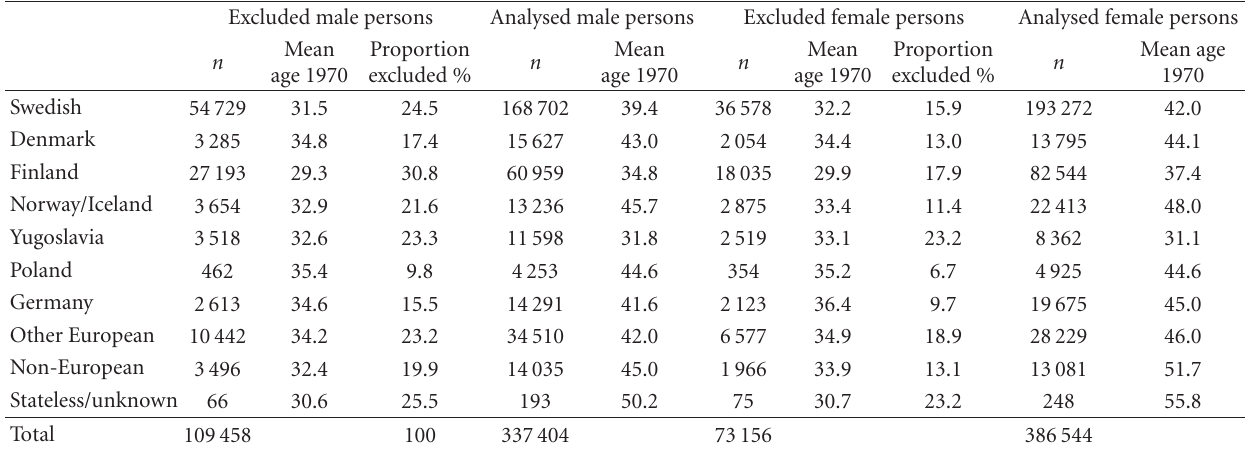
Table 1: Excluded and analysed persons related to country of birth, sex, and